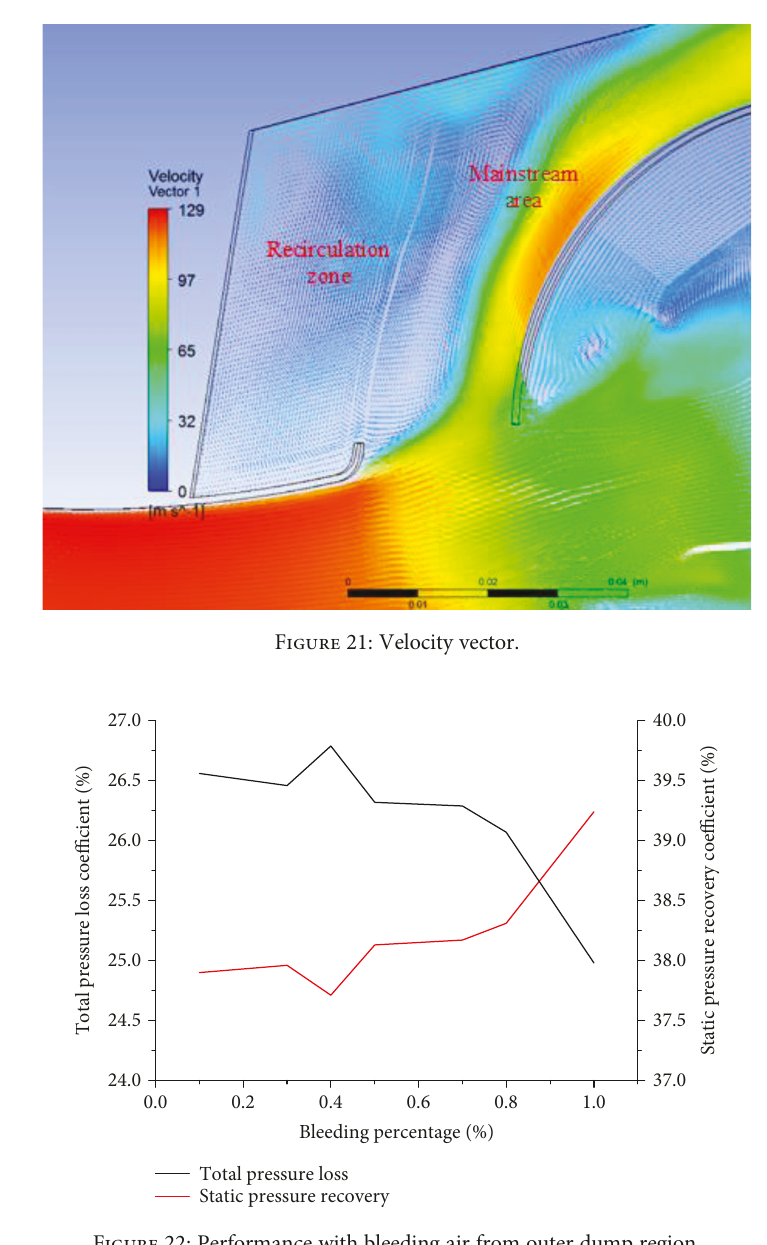
Figure 22: Performance with bleeding air from outer dump region. Table 10: Calculation